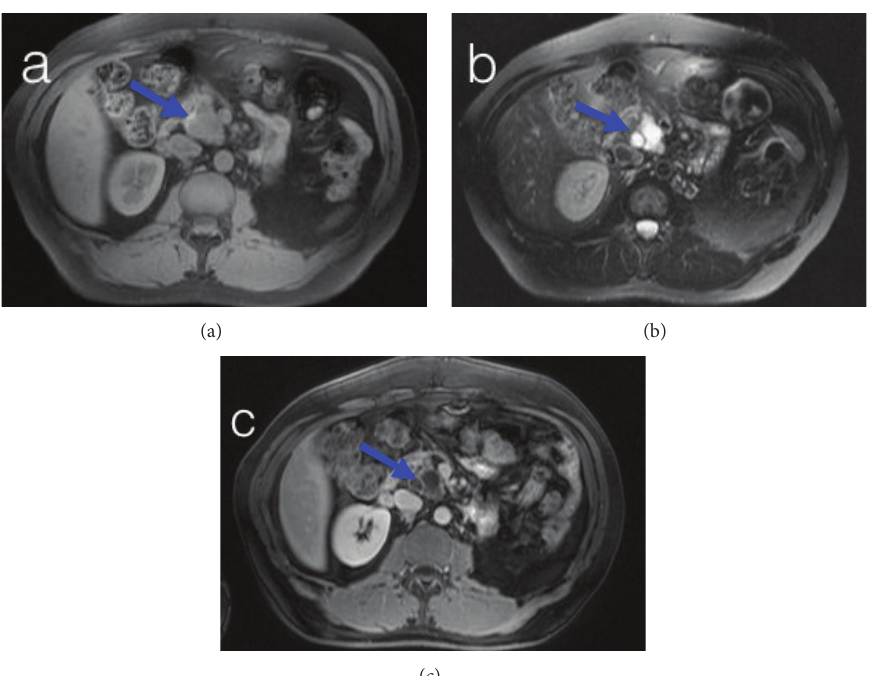
Figure 1: The scans show a multichambered lesion, 3.3 × 2.5 cm in size, localized in the head and in the uncinate process of the pancreas, hypointense in T1-weighted image (a) and hyperintense in T2-weighted image (b). After the intravenous contrast medium administration (c), the enhancement of the capsule and internal septa was shown. (a) Precontrast axial T1-WI FAT SAT. (b) Precontrast axial T2-WI FAT SAT. (c) Postcontrast axial T1 WI. The blue arrow indicates the